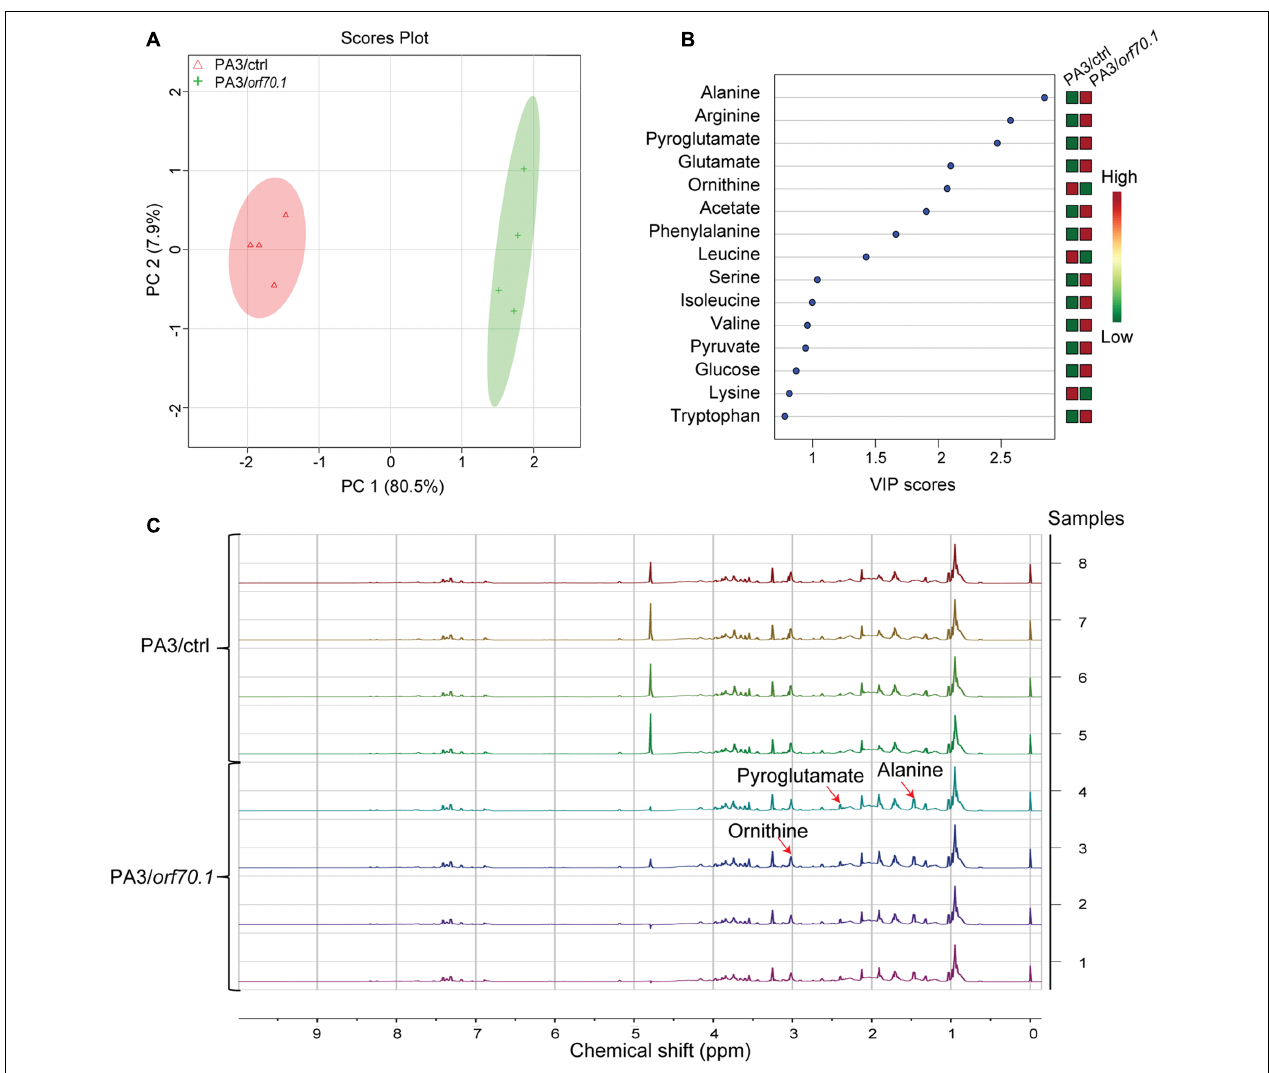
FIGURE 6 | Influence of gp70.1 on the metabolite consumption of PA3. (A) Score plot of PCA (Principle Component Analysis) of the normalized NMR data from eight samples. It was constructed based on the first two principle components (PC1 and PC2). PC1 corresponds to 80.5% of total variance and PC2 corresponds to 7.9%. (B) Variable importance in projection (VIP) analysis is used to show the significantly changed metabolites. The higher VIP-score means the more significant difference. The concentrations of metabolites are color-coded: red for high and green for low concentration. (C) 1 H-NMR spectra of eight samples (four biological replicates in each group). NMR spectra were reported with chemical shift range from 0 to 10 ppm. Three peaks assigned to three differential metabolites (alanine, pyroglutamate, and ornithine) were illustrated by red